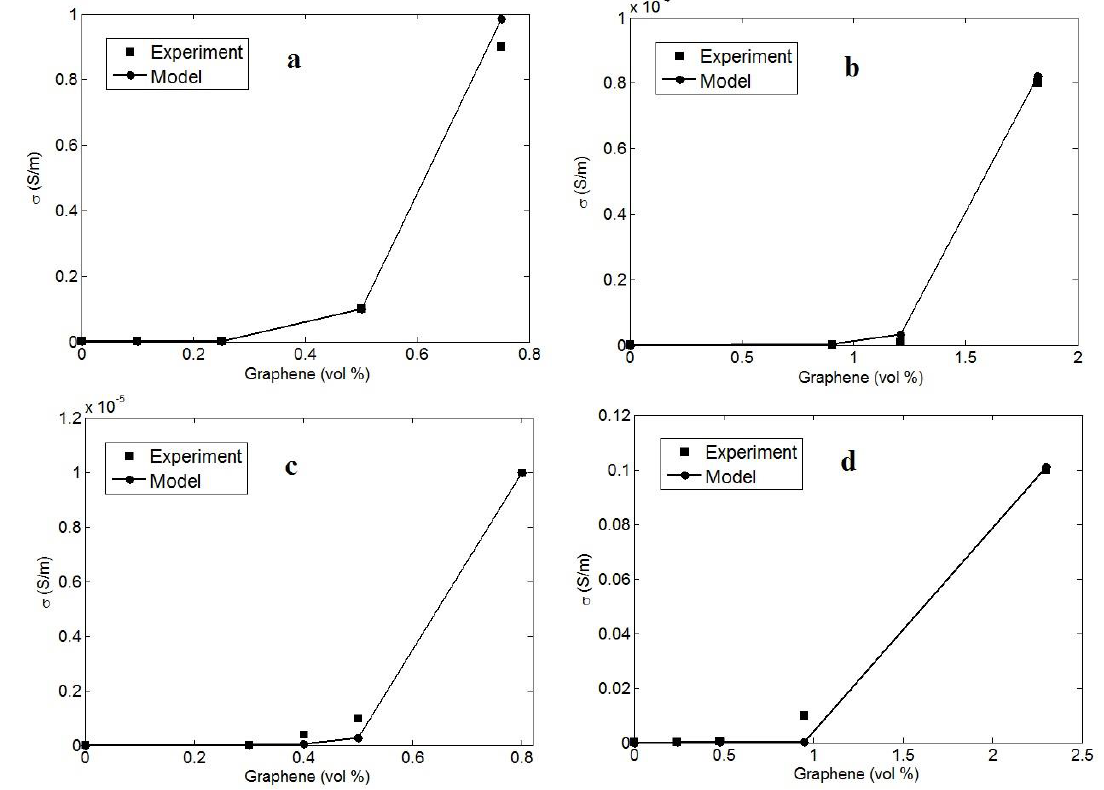
Figure 2. The experimented and calculated conductivity using the novel model for ( a ) PS [59], ( b ) epoxy [60], ( c ) PVDF [29] and ( d ) ABS [61] graphene systems. The values of the “b” exponent can be applied using Equation (8) to approximate the level of “N”. The calculated “N” for all samples is reported in Table 1. “N” ranges from 1.5 to 22 for the reported examples. As recommended, “N” is a representative of the di- mension and density of filler net. So, a higher “N” shows the creation of bigger and thicker nets in the sample. It can be suggested that sample No. 2 contains the biggest and the densest nets among the reported samples. Additionally, an inverse relation between “N” and “b” is extracted from the reported calculations in Table 1. The samples with high “N” illustrate small “b”, while a low “N” results in a high “b”. This evidence is logical, because the big and dense nets of graphene produce a strong conductivity in the nano- composite as predicted by low “b” (see Figure 1b). Conclusively, Equation (8) success- fully states the possessions of interphase depth, tunneling distance and net dimensions on the “b” exponent. In other words, the suggested equation for “b” considers the in- fluence of all main factors, which may govern the percolation start and the nets of gra- phene nano-sheets in the nanocomposite. In the absence of accurate experimental tech- niques for the characterization of interphase, tunneling and net dimensions/density, the developed equations for percolation start and “b” exponent in this study can help ap- proximate these parameters in polymer graphene nanocomposites. 3.2. Parameters’ Effects on the “b” The stimuli of parameters on the “b” exponent are discussed using Equation (8). Figure 3 exemplifies the characters of “t i ” and “d” in the “b” at t = 2 nm, D = 1 μm and N = 10. The highest value of “b” as 9.5 is observed at t i = d = 2 nm, while “b” de- creases to about 4.15 at t i > 10 nm and d > 8 nm. Consequently, the high values of both “t i ” and “d” decrease “b”. In other words, thick interphase and long tunneling distance can